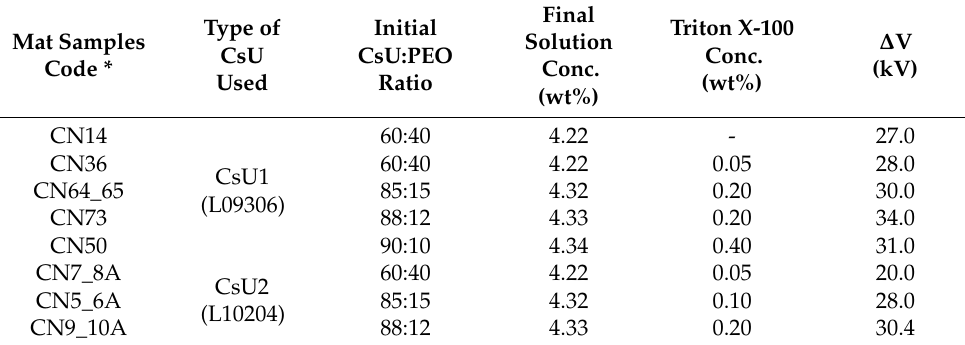
2 and 3. Table 2. Electrospinning conditions: solution composition and voltage. Table 2. Electrospinning conditions: solution composition and voltage. Mat Samples Mat Samples